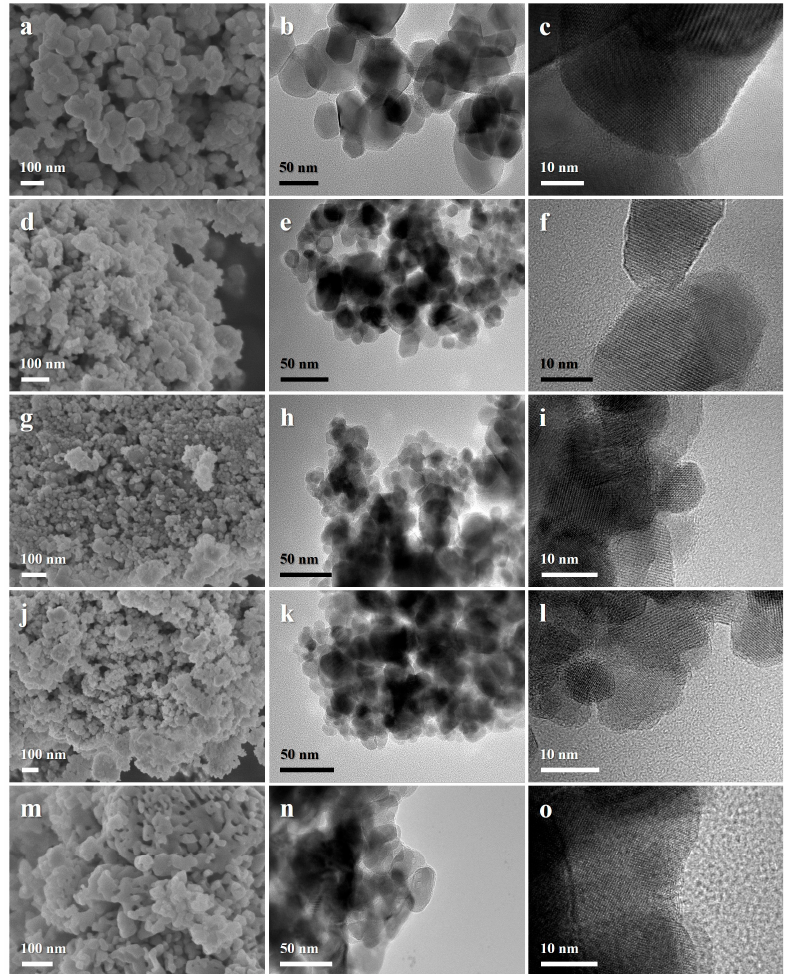
Figure 1. SEM and HRTEM images of Co 3 O 4 ( a – c ), Mn 0.025 Co 1 ( d – f ), Mn 0.05 Co 1 ( g – i ), Mn 0.1 Co 1 ( j – l